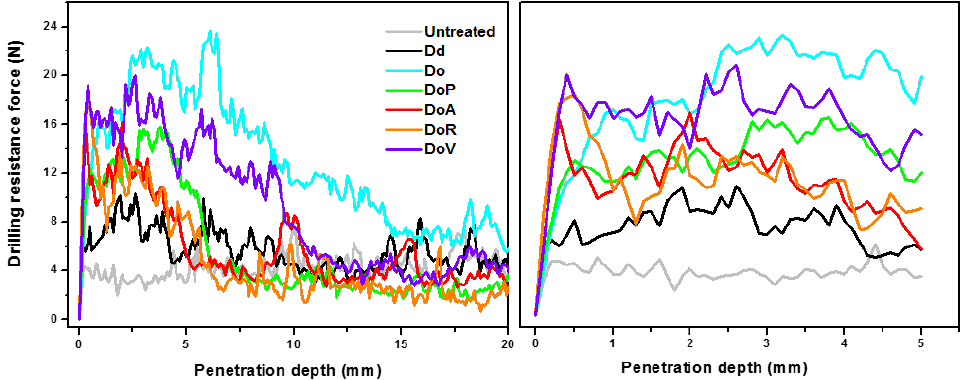
Figure 5. SEM images of the surfaces of the untreated stones and their treated counterparts: ( a ) Untreated, ( b ) Dd, ( c ) Do, ( d ) DoP, ( e ) DoA, ( f ) DoR, ( g ) DoV.